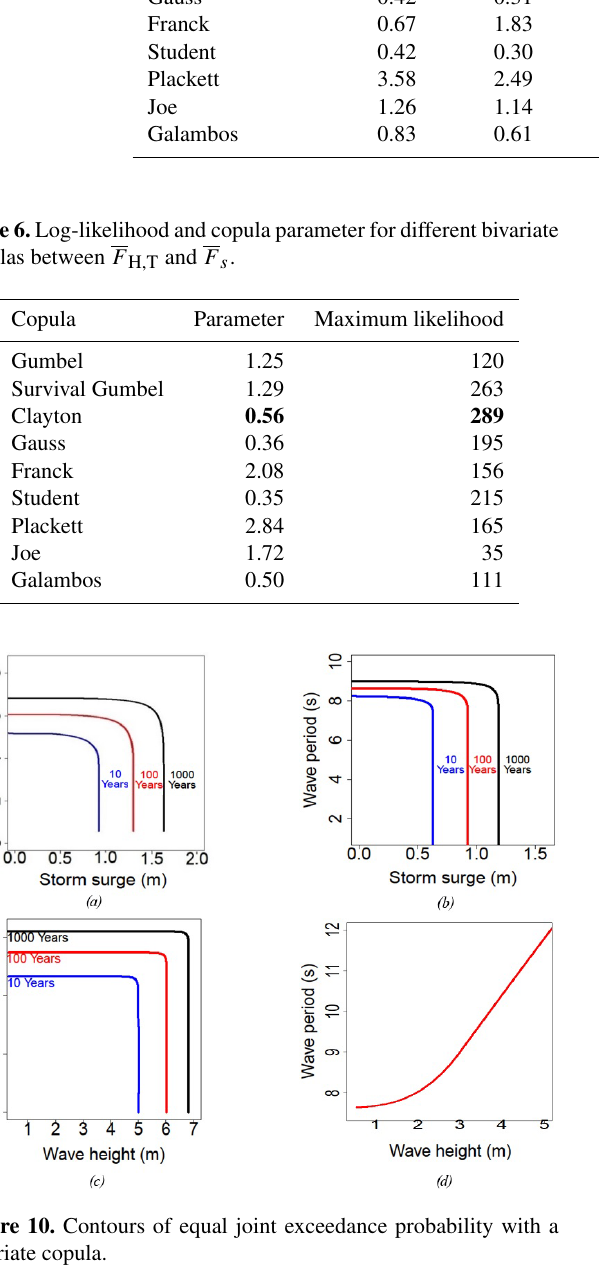
Maximum likelihood likelihood likelihood